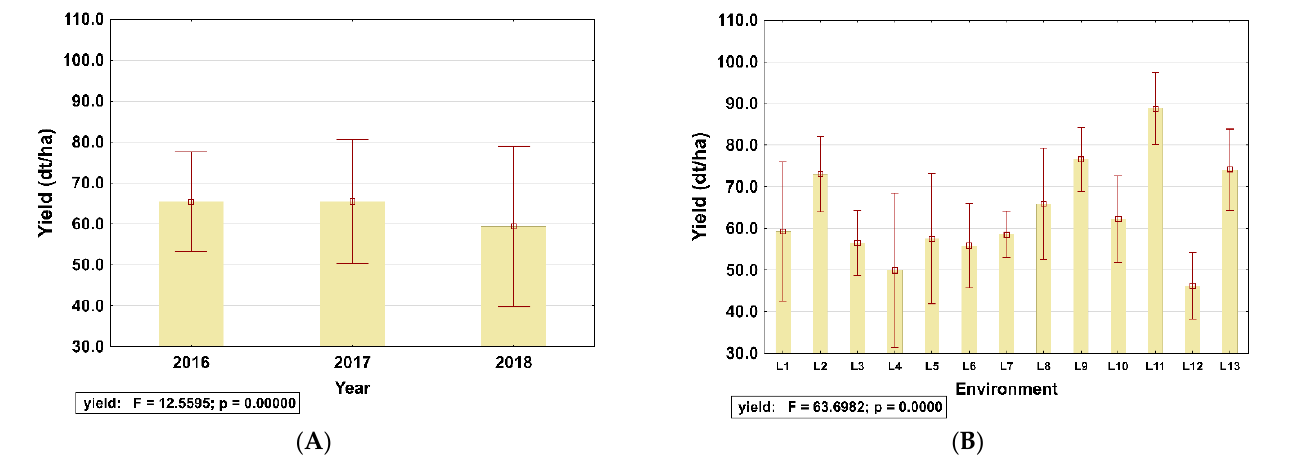
Figure 1. Average barley grain yields in dt/ha harvested from 20 varieties growing at randomized experiments at thirteen environments (L1–L13) in 2016, 2017, and 2018. ( A ) presents average yields harvested from 20 varieties in 2016, 2017, and 2018 ( A ). ( B ) presents average yields harvested from 20 varieties in 13 environments (L1–L13) in 2016–2018 ( B ). Analysis of variance (ANOVA test; α ≤ 0.05) values, which are presented under the figures, confirm the significant differences for grain yield harvested from 20 varieties between years ( A ) and differences for grain yield harvested from 20 varieties in 13 environments ( B ). The bars represent mean value and standard deviation (SD) for each year and environment.